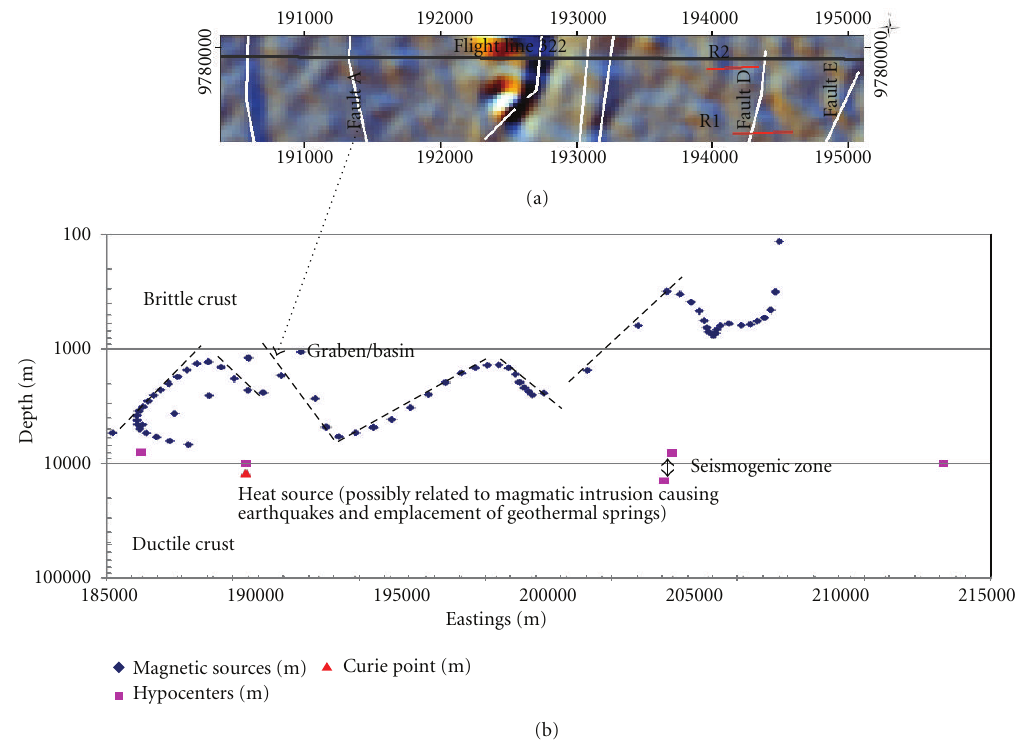
Figure 16: (a) Hill-shaded aster DEM subset showing the surface lineaments and the extracted aeromagnetic flight line 322. (b) Scatter Plots showing the subsurface relationship between magnetic sources on flight line 322, the hypocenters and the Curie-point (heat source). The magnetic sources are generated from 2D Euler deconvolution using structural index of 1 (i.e., contacts, faults) with inclinations and declination angles of − 26.3 ◦ and 0.002 ◦ , respectively. R1 and R2 are the resistivity profiles 1 and 2,